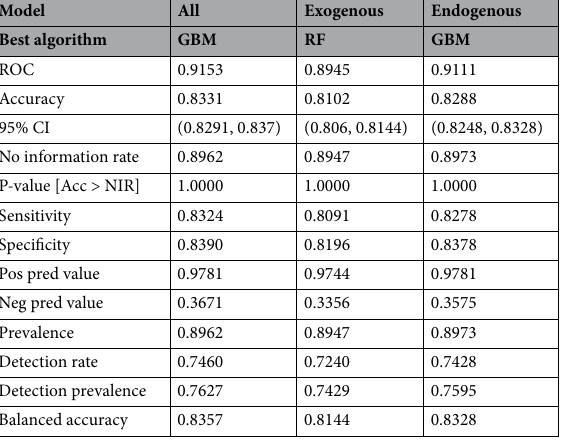
Table 3. Accuracy performance indicators for European universities’ co-publication prediction in Social Sciences and Humanities domain. Three models considered: with all, with only exogenous, and with only endogenous features.